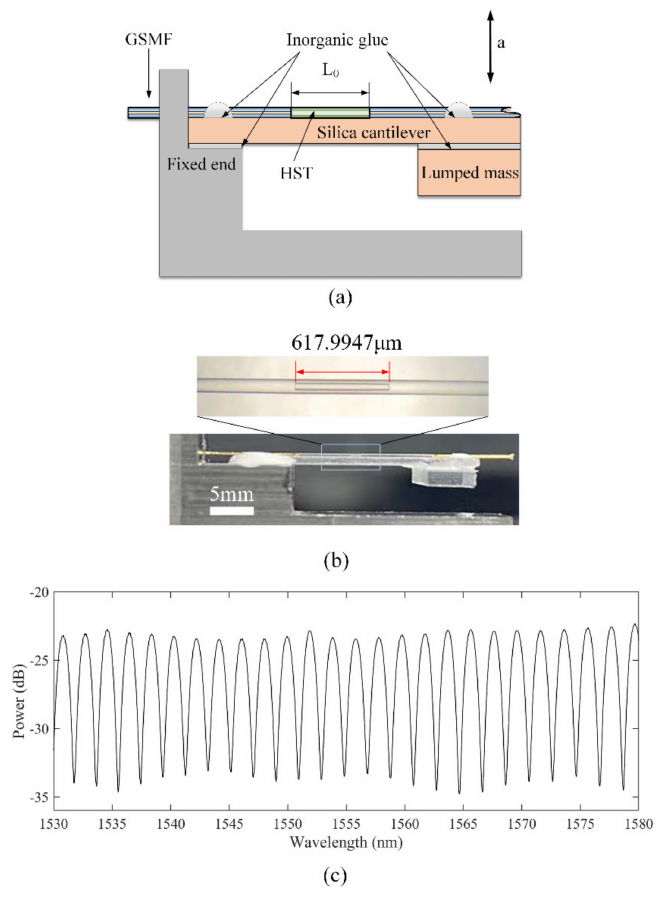
Figure 1. Schematic of the FOFPA based on all silica ILFFPE. ( a ) schematic of the FOFPA. ( b ) photograph. ( c ) spectrum of the